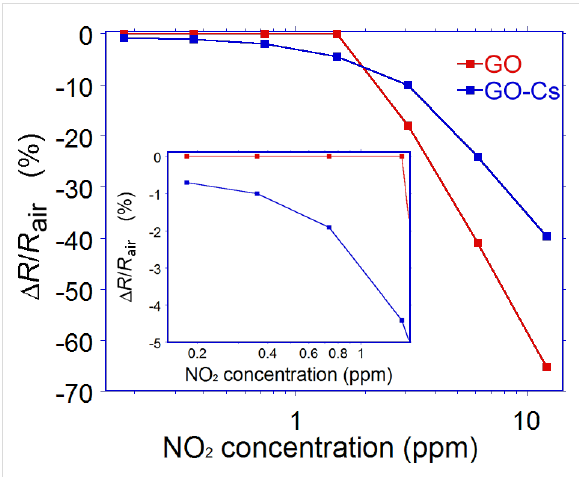
Figure 5: Response of the GO and GO-Cs based sensors as a func- tion of NO 2 concentration. The inset shows the response at very low concentrations.